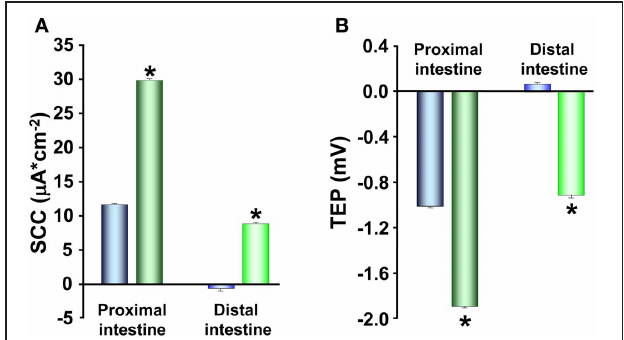
FIGURE 5 | Short-circuit current (SCC; A) and transepithelial potential (TEP; B) in proximal and distal intestine of control ( , ) and cortisol ( , ) implanted rainbow trout acclimated to fresh water. Values presented are means ± SEM ( n = 8). Asterisks indicate significant differences between cortisol treated and control trout, in each region of the intestinal tract. All data are expressed as mean values ± SEM. Differences in the parameters measured are analyzed using Two-Way ANOVA of variance, followed by Student Neuman Keuls post hoc procedure. Significance was accepted at p < 0 . 05 (see Sundell et al., 2003; Jutfelt et al., 2007; Sundh et al., 2009).